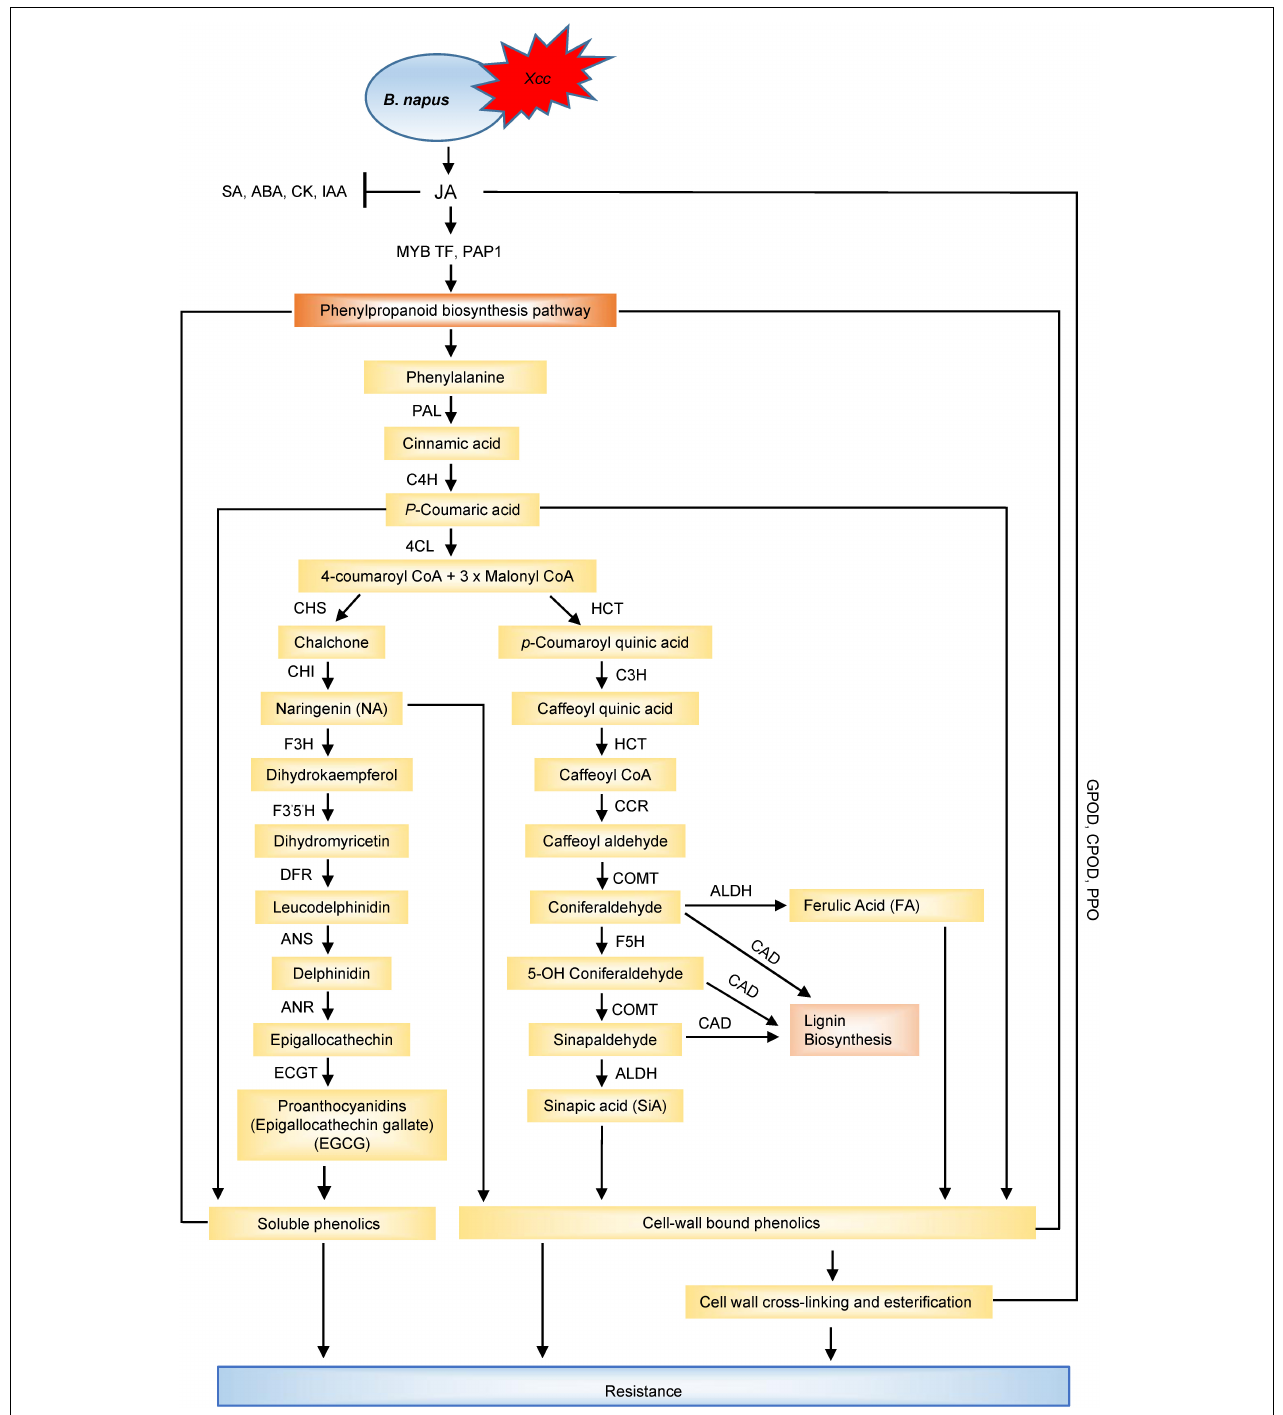
FIGURE 4 | Schematic view of a model depicting Jasmonic acid (JA) -mediated phenylpropanoid biosynthesis pathway and hormonal regulations of phenolic accumulation (soluble and cell-wall bound) in relation to resistance against Xcc in Brassica napus adopted from previous studies (Islam et al., 2018, 2019b). JA, jasmonic acid; SA, salicylic acid; ABA, abscisic acid; CK, cytokinin; IAA, indoleacetic acid; MYB TF, MYB transcriptional factor; PAP1, production of anthocyanin pigment 1; PAL, phenylalanine ammonia-lyase; C4H, cinnamate-4-hydroxylase; 4CL, 4-coumaroyl CoA-ligase; CHS, chalcone synthase; CHI, chalcone isomerase; F3H, flavanone 3- hydroxylase; F3’5’H, flavonoid 3’,5’hydroxylase; DFR, dihydroflavanol 4-reductase; ANS, anthocyanidin synthase; ANR, anthocyanidin-reductase; ECGT, epicatechin:1- O -galloyl- β - D -glucose- O -galloyltransferase; HCT, hydroxycinnamoyl-CoA:shikimate hydroxycinnamoyl transferase; C3H, coumarate 3-hydroxylase; CCR, cinnamyl CoA reductase; COMT, caffeic acid O methyltransferase; ALDH, aldehyde dehydrogenase; F5H, ferulate 5- hydroxylase; CAD, cinnamyl alcohol dehydrogenase; GPOD, guaiacol peroxidases; CPOD, coniferyl alcohol peroxidase; PPO, polyphenol oxidase.